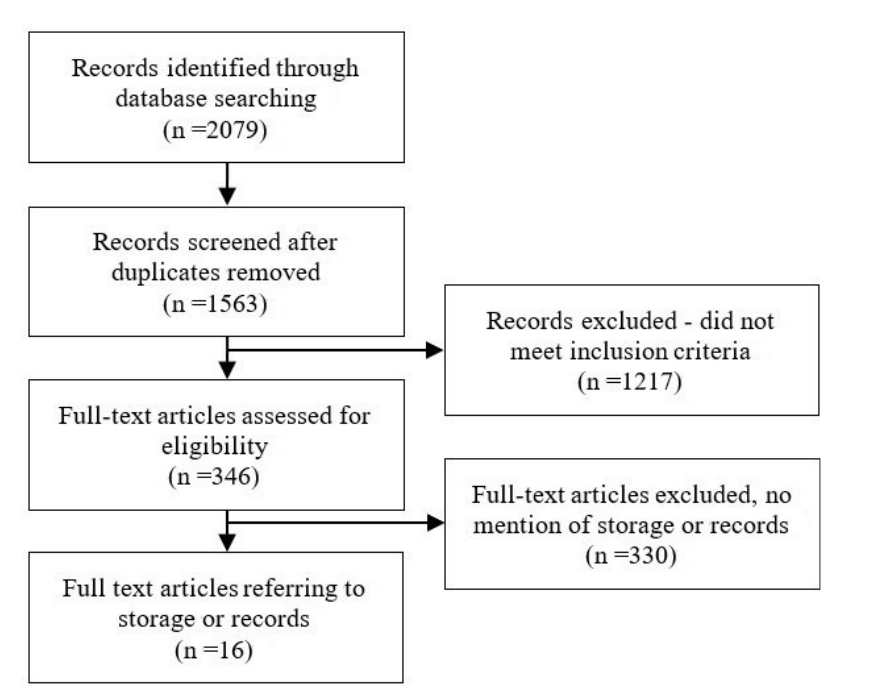
Figure 1. PRISMA Flow Diagram of the Search Process.